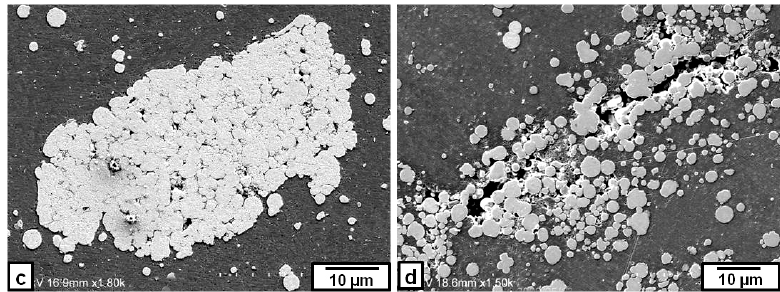
Figure 4. SEM image of the Fe particles dispersed in some areas produced by triple FSP passes at a rotation speed of 1500 rpm: ( a ) nugget center; ( b ) area involving Fe particles of high density; ( c ) Fe particles cluster; and ( d ) cracks in an area involving Fe particles of high density.